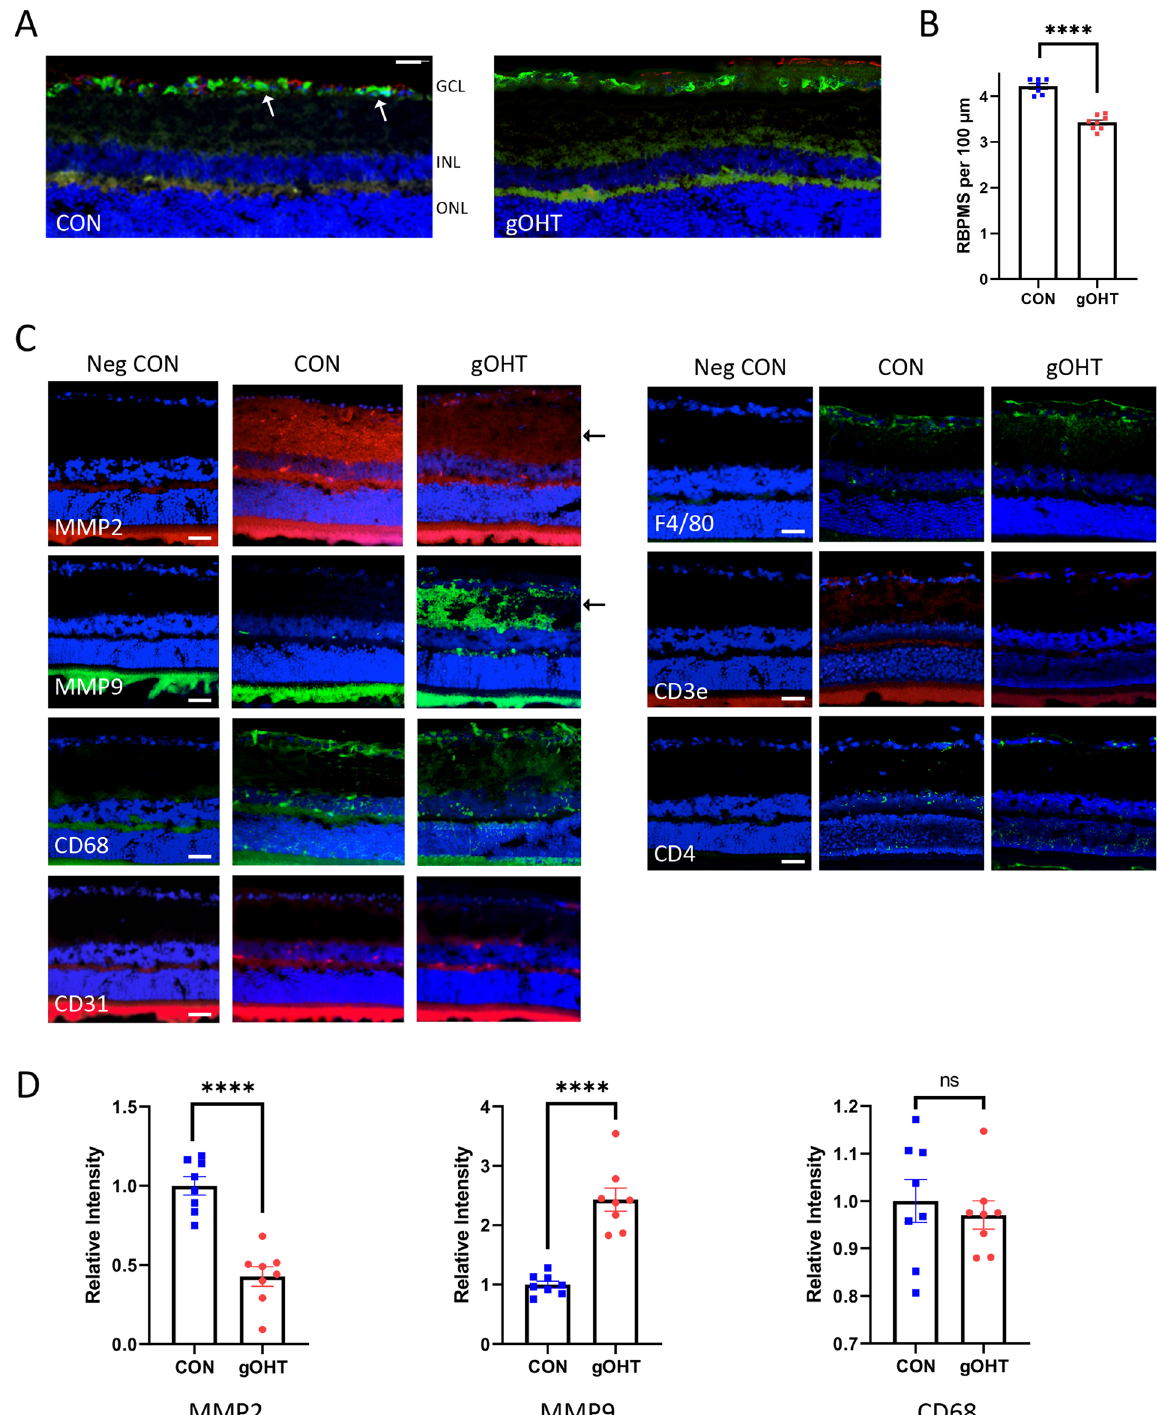
Figure 3. Chronic gOHT results in inner retinal neuropathology. ( A ) Representative retinal images from CON and gOHT eyes after 17 weeks in the gOHT group, stained for RBPMS (green, arrows) and GFAP (red), in addition to the nuclear marker DAPI (blue) (scale bar indicates 50 μm). ( B ) Corresponding quantification of RGC density indicates significantly decreased survival in gOHT compared to CON (****p < 0.0001, bars are SE). ( C ) Representative immunostaining panels of CON and gOHT retinas in the same orientation. MMP-2 signal decreased and MMP-9 signal is increased in the gOHT inner retina compared to CON eyes (arrows). There was no notable difference in staining for CD68, CD31, F4/80, CD3e or CD4 between gOHT and CON. Note: negative controls (Neg CON) are sections stained with a secondary antibody alone. (scale bars indicate 50 μm). ( D ) Quantification of staining across image sets shows a significant decrease for MMP2, a significant increase for MMP9, and no change for CD68 markers (n = 8, bars are SE, ****p < 0.0001, ns; not significant). GCL, ganglion cell layer; INL, inner nuclear layer; Neg CON, Negative Control; ONL, outer nuclear